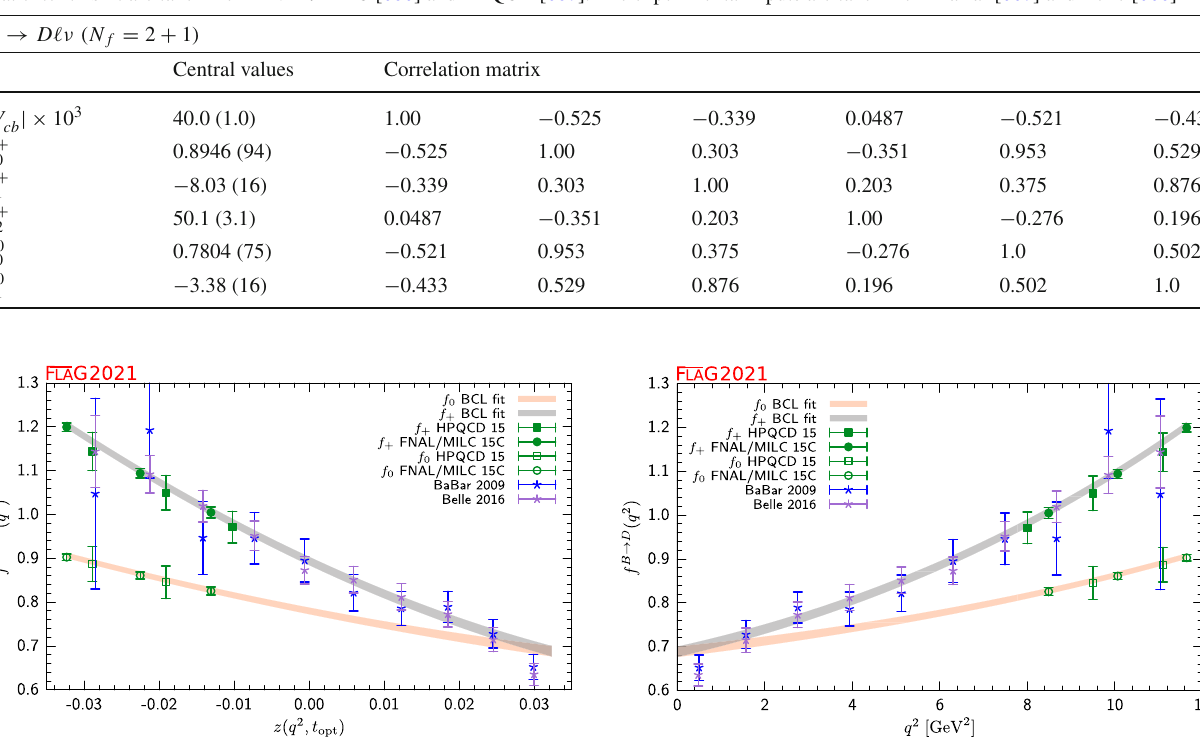
( q 2 ) versus z (left panel) and q 2 (right panel). Green symbols denote lattice-QCD Fig. 36 Lattice and experimental data for f B → D + ( q 2 ) and f B → D 0 points included in the fit, while blue and indigo points show experimental data divided by the value of | V cb | obtained from the fit. The grey and orange bands display the preferred N + = N 0 = 3 BCL fit (five z -parameters and | V cb | )